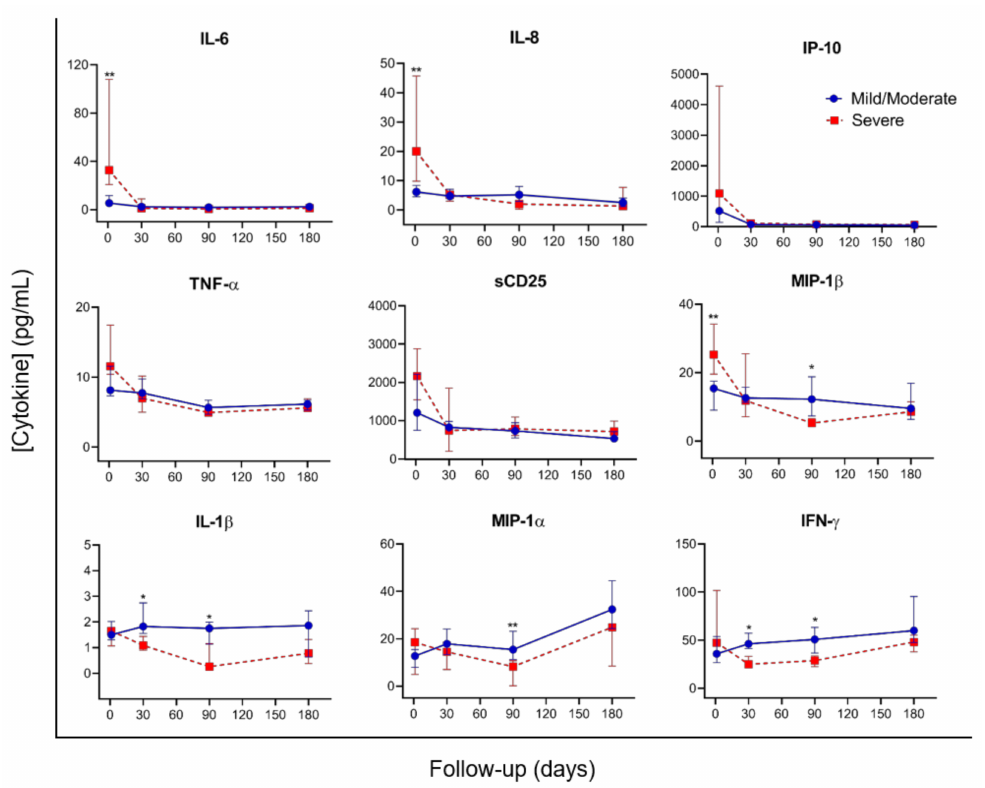
Figure 3. Cytokine kinetics in patients with mild/moderate versus severe COVID-19 during the study period. Cytokine levels are expressed as median ± IQR. The solid blue line with circles represents the mild/moderate group ( n = 12) and dotted red line with squares represents severe group ( n = 6). Differences between both groups at each time point were assessed using Mann–Whitney U test. *, p -value < 0,05; **, p -value <